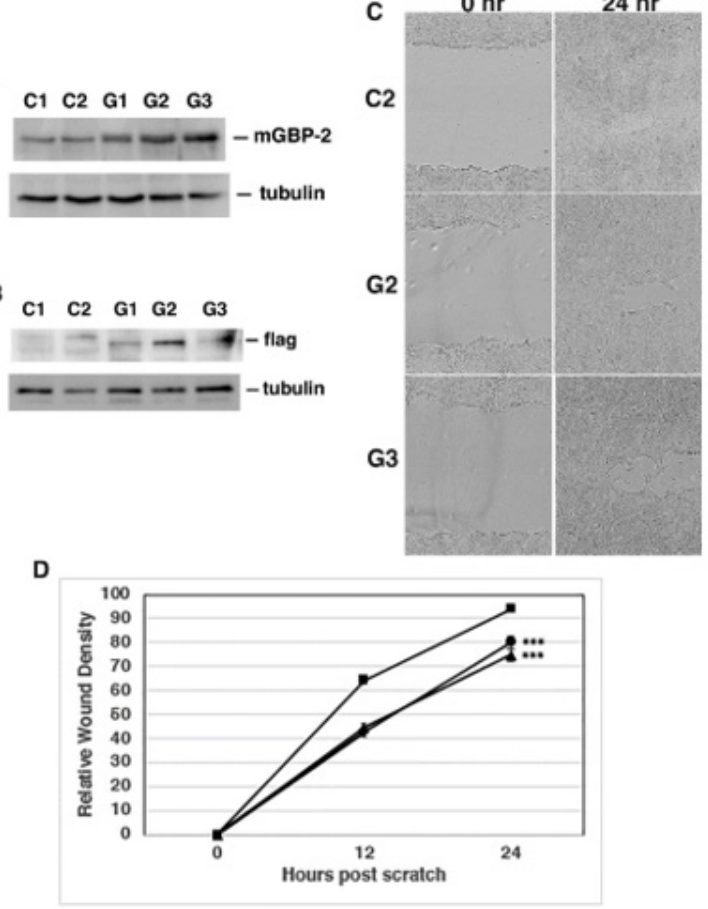
Figure 4. GBP-2 inhibits 4T1 cell migration. 4T1 cells were infected with lentivirus expressing flag-tagged GBP-2 as described in Methods. Cell lysates from two cell lines with control lentivirus (C1 and C2) and three lines (G1, G2, G3) with flag-tagged mGBP-2 were probed with either a polyclonal antisera (1851) against GBP-2 (panel A ) or anti-Flag (panel B ) and anti- α -tubulin. Representative images are shown ( n = 2). ( C ). 4T1 cells ± GBP-2 were analyzed by wound healing assay for changes in migration, as described in Methods. Representative photomicrographs of wounds generated by scratch in C2, G2, and G3 cell monolayers at 0 and 24 h post scratch are shown at 10× magnification. ( D ). Results are presented as mean relative wound density ± SEM ( n = 2; ***, p < 0.001). A square designates C2, a circle designates G2, and a triangle designates G3.